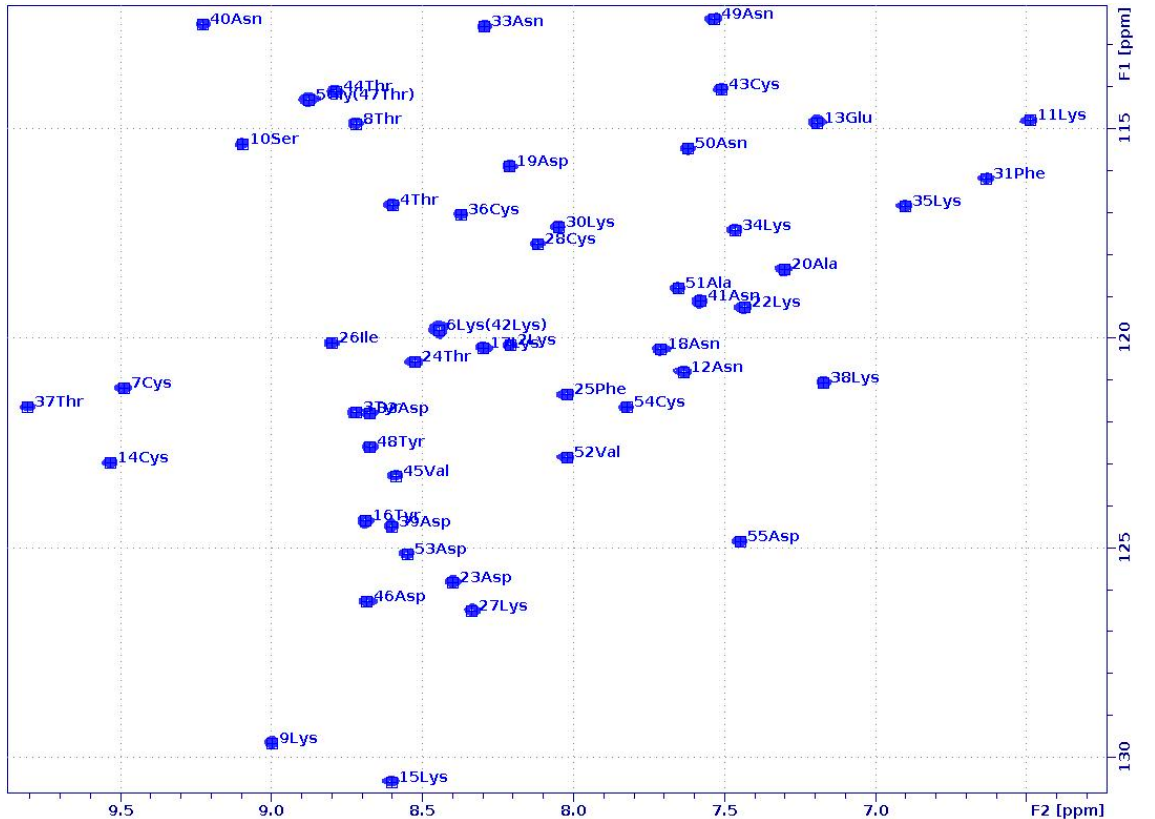
Figure 1. The assigned 1 H ‐ 15 N HSQC spectrum of the PAF in the presence of 50% DMSO, added to an acetate buffer (pH 4.5), as measured with a NEO 700 MHz spectrometer (Bruker) at 310 K temperature. Residue specific NH peak assignments are labelled: see also BMRB 34655 deposition in case of overlap.